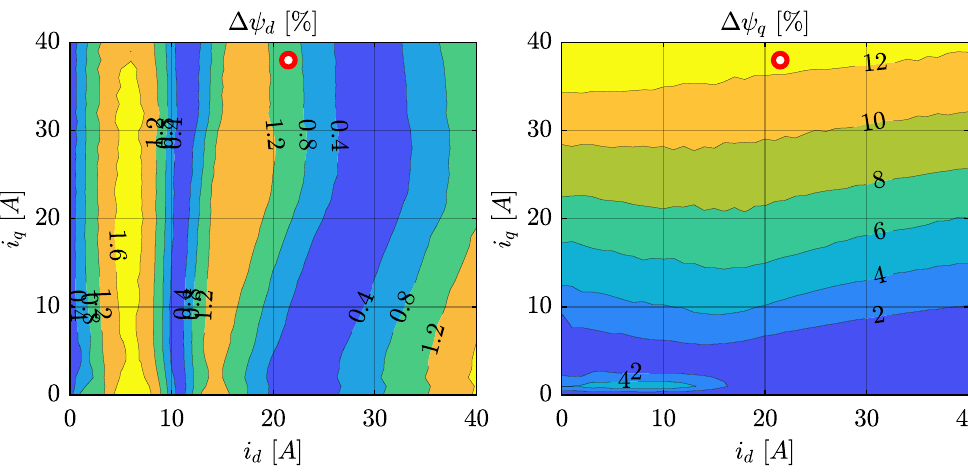
Figure 10. Flux linkage estimation difference d -axis ( left ) and q -axis ( right ) for the CSM.